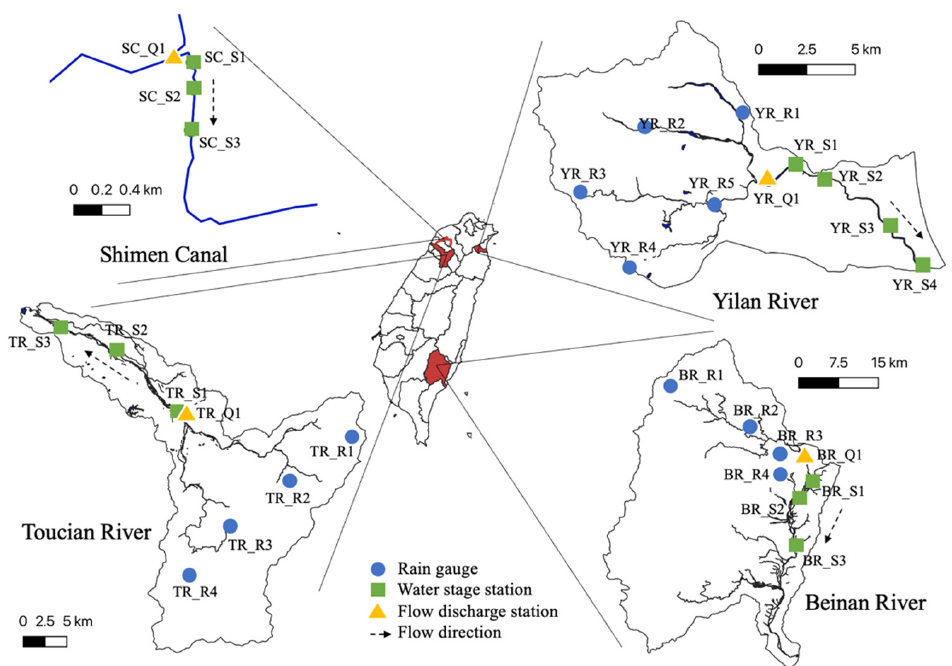
Figure 1. The four study areas are the Shimen canal in Taoyuan County (upper left), the Yilan River in Yilan County (upper right), the Beinan River in Taitung County (bottom right), and the Toucian River in Hsinchu County (bottom left), Taiwan.